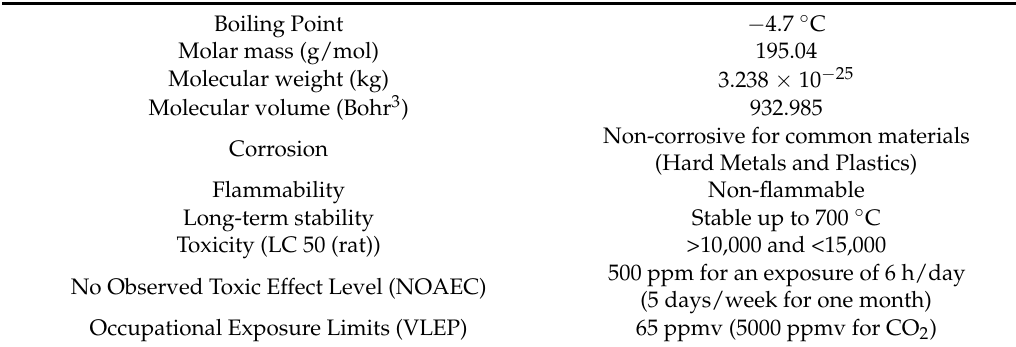
Table 12. Important properties of (CF 3 ) 2 CFCN [52].